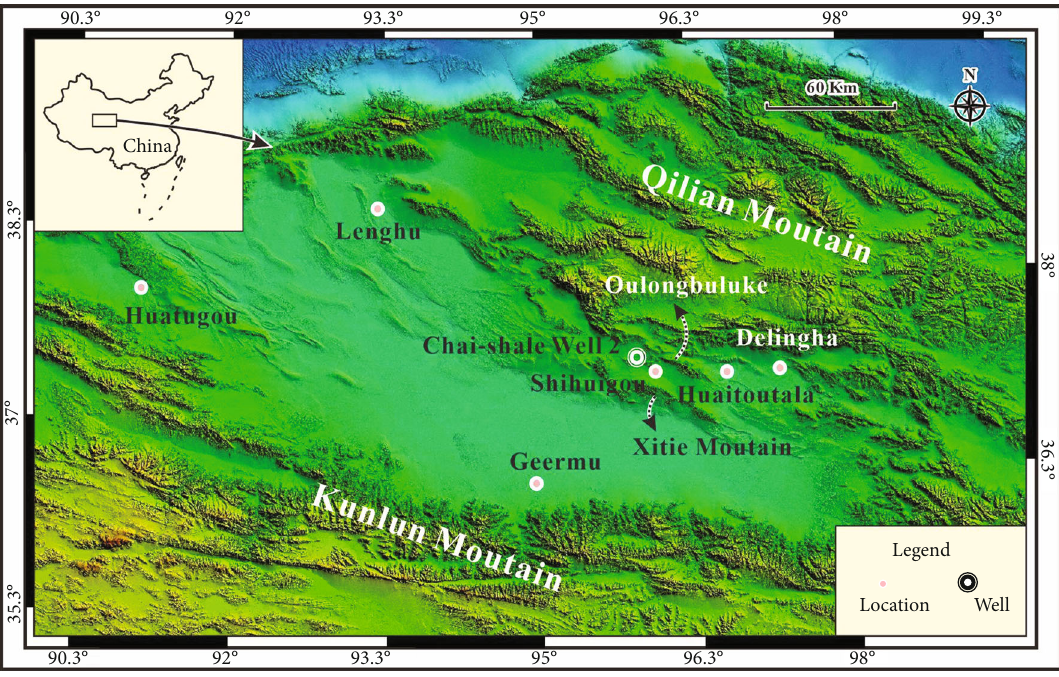
Figure 1: Location map of study